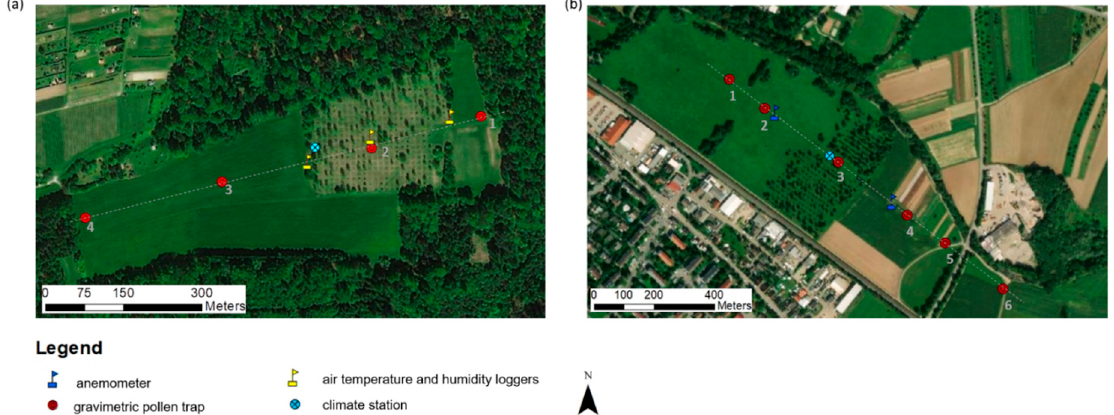
Figure 1. Study areas: ( a ) seed plantation near Schorndorf (48°46 ′ N, 9°25 ′ E, 420 m a.s.l.), ( b ) seed plantation near Emmendingen (48°6 ′ N, 7°52 ′ E, 209 m a.s.l.) including measurement sites: red circles—gravimetric pollen traps; yellow flags—air temperature and humidity loggers; blue flags—anemometers; blue circle—climate station. Source of the map: Esri, DigitalGlobe, GeoEye, Earthstar Geographics, CNES/Airbus DS, USDA, USGS, AeroGrid, IGN and the GIS User Community.